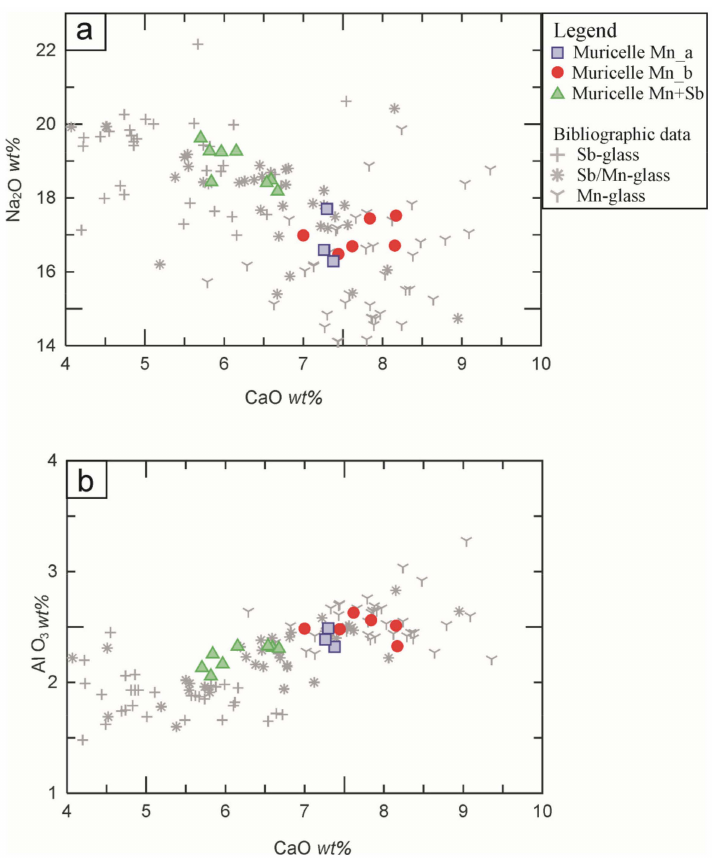
Figure 4. ( a ) CaO versus Na 2 O; ( b ) CaO versus Al 2 O 3 . The bibliographic data refer to coeval Roman glasses